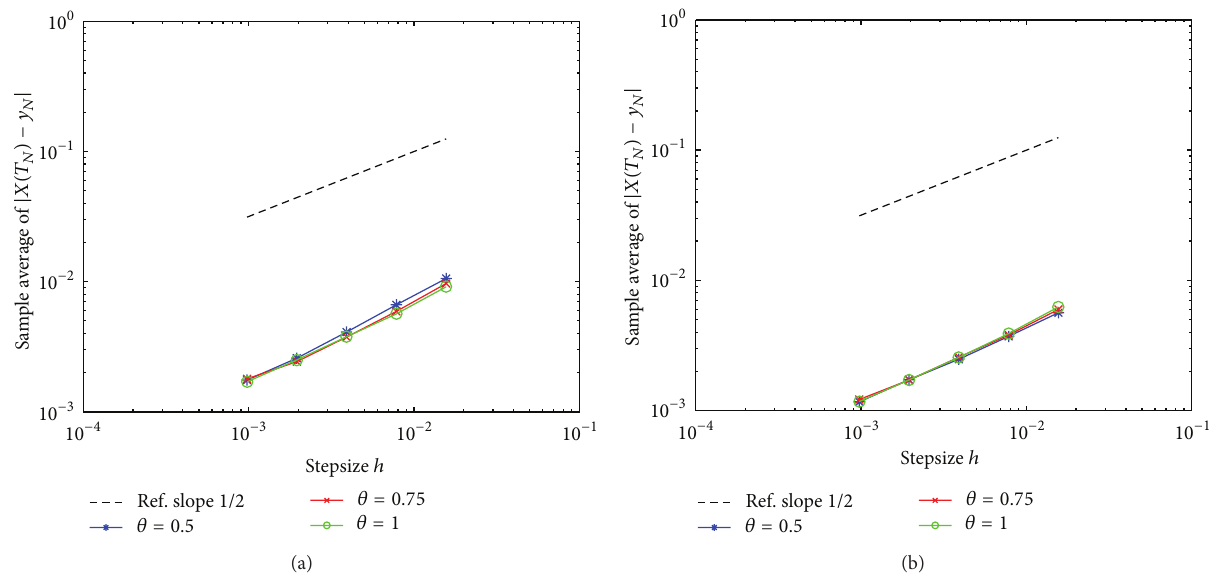
Figure 1: log 𝜖 with 𝑡 𝑁 = 2 versus log ℎ for SST method (3) solving SDDEs (54) (a) and SDDEs (55)